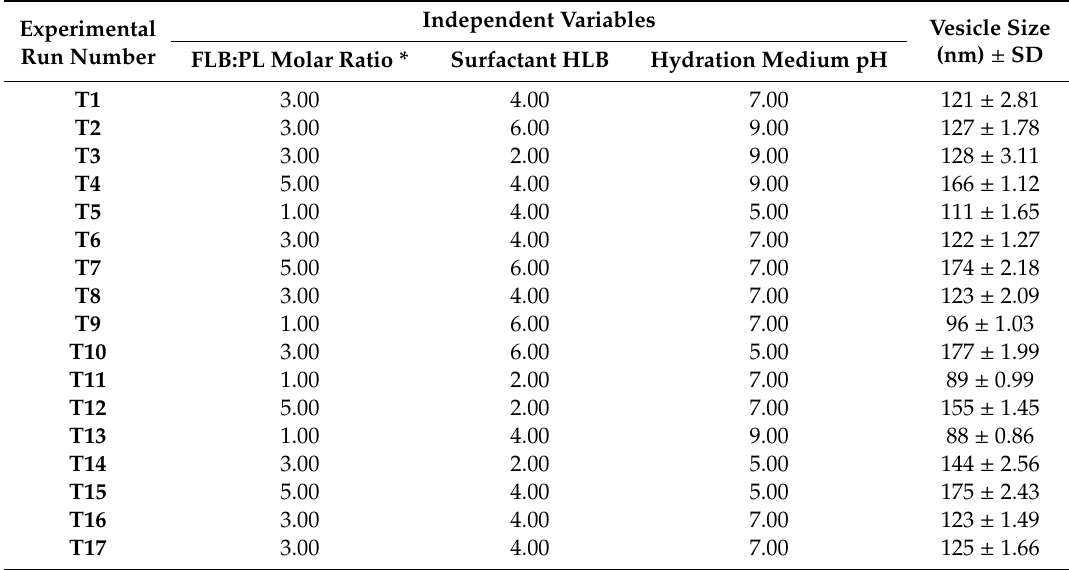
Table 1. Experimental runs and the observed vesicle size of flibanserin (FLB) transfersomes (TRFs) according to Box–Behnken